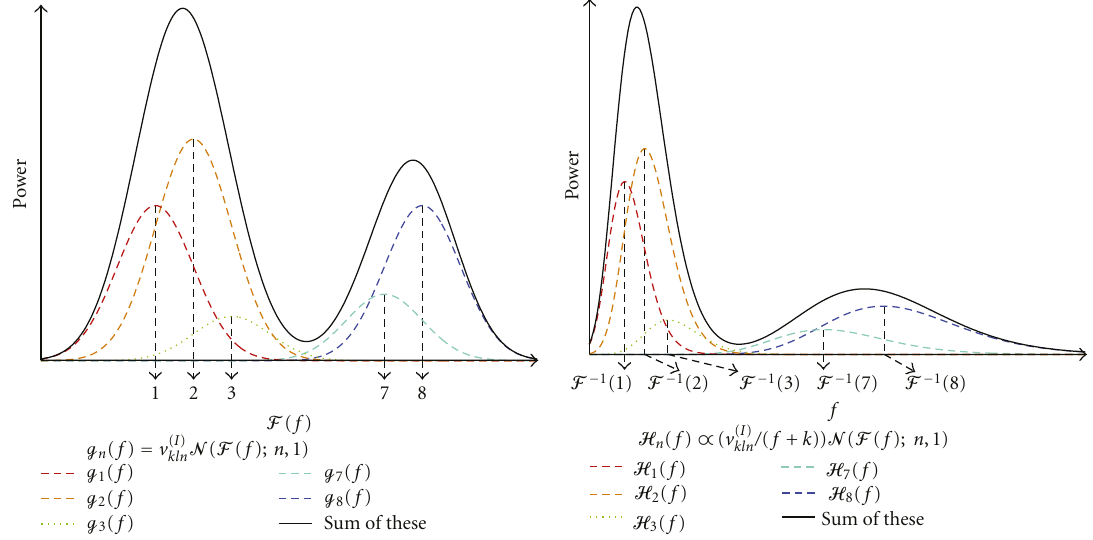
Figure 5: Frequency structure of inharmonic tone